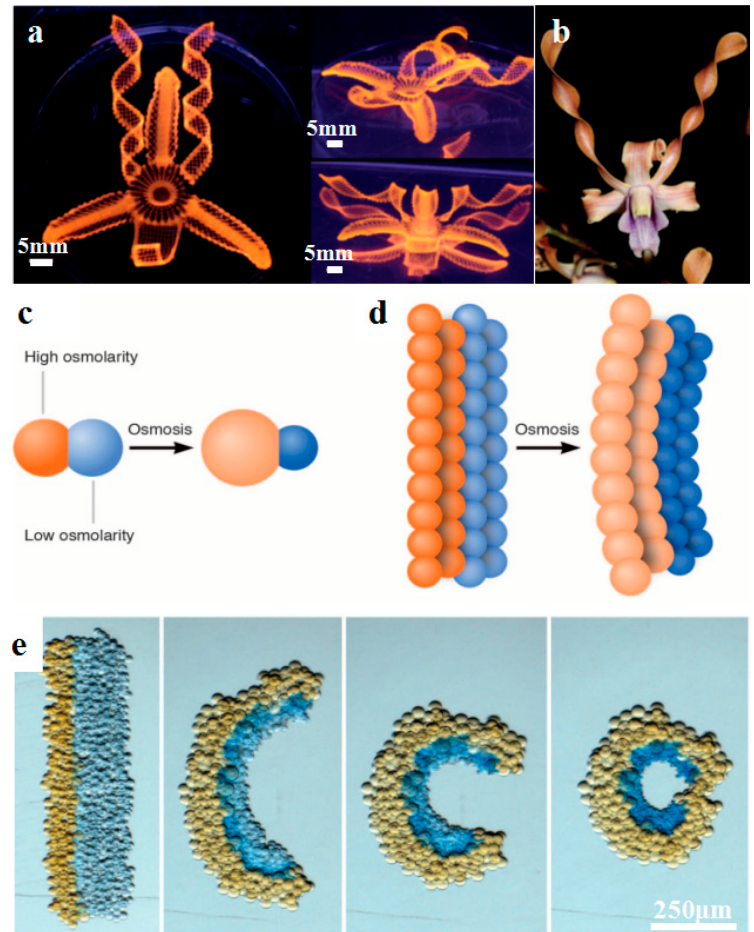
Figure 7. Shape-shifting structures fabricated by 4D printing. ( a , b ) Biomimic shape-shifting flowers, reprinted from [87] with the permission of Nature Publishing Group, Copyright 2016; ( c ) Schematic of two droplets of different osmolarities joined by a lipid bilayer. The flow of water through the bilayer causes the droplets to swell or shrink; ( d ) Schematic of a droplet network that comprises two strips of droplets of different osmolarities. The transfer of water between the droplets induces an overall deformation of the network; ( e ) Photographs of a rectangular network folding into a circle over about 3 h, reprinted from [88] with the permission of The American Association for the Advancement of Science, Copyright 2013.